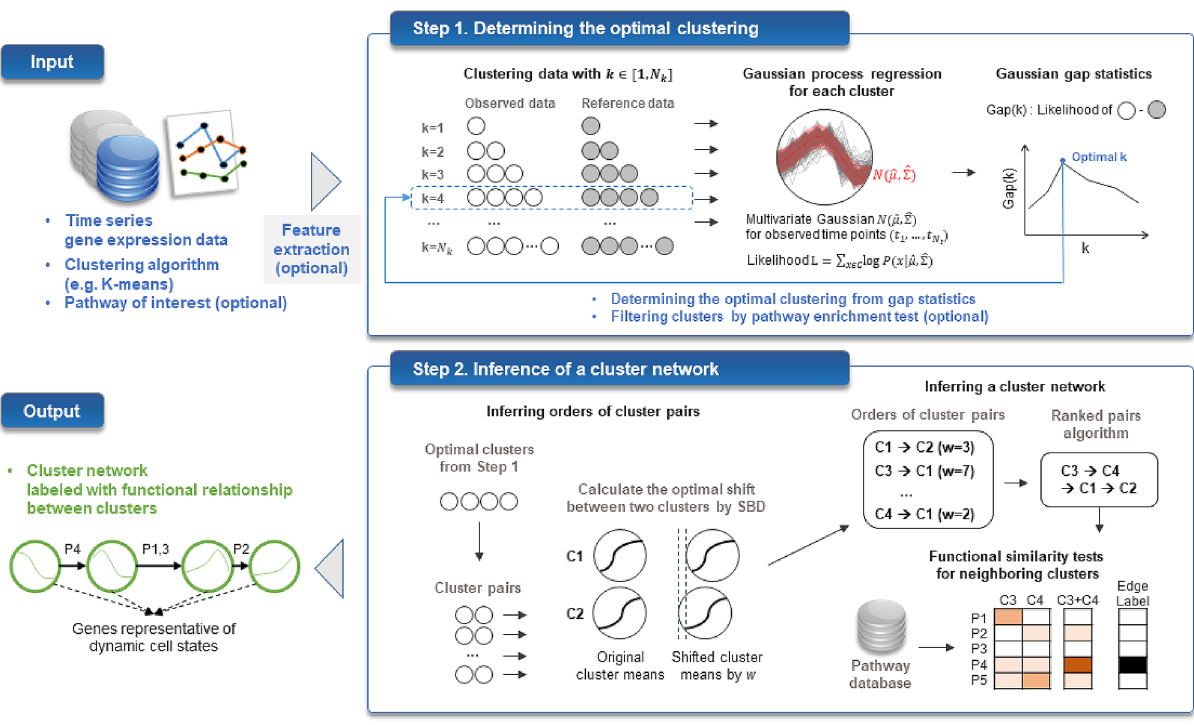
Figure 1. Overview of TRACS. From time series gene expression data, TRACS determines the optimal clustering of time series gene expression data using Gaussian gap statistics (Step 1). With the optimal clustering result, a network of clusters is generated and visualized to track the dynamic expression patterns of clusters and their relationships (Step 2). The final output of TRACS is a cluster network describing dynamic cell states and transitions by ordered clusters, where cluster genes imply representative genes of each cell state. Functional relationships between clusters (cell states) are statistically tested and annotated on network